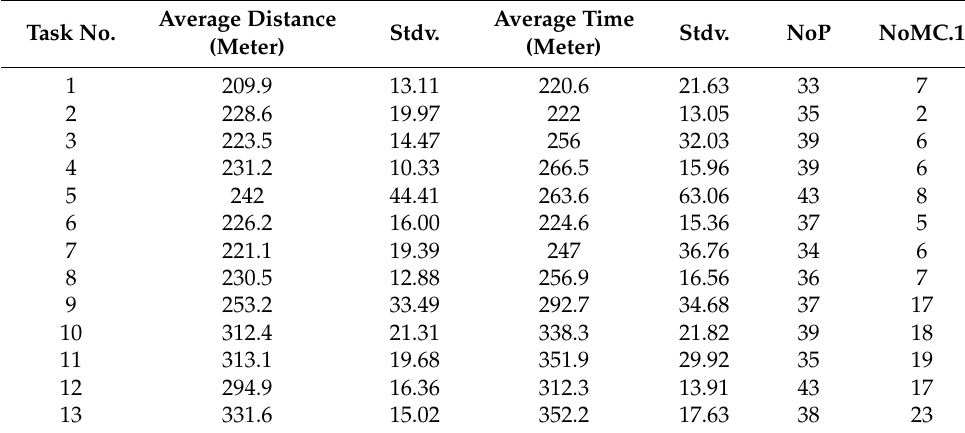
Stdv. Table 3. Summary of the data recorded from the Ruka 2nd VR .